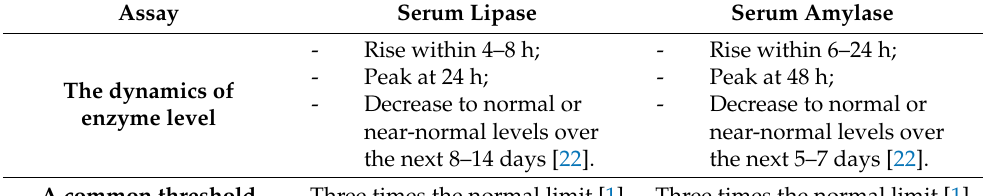
Table 2. Cont. Assay Serum Lipase Serum Amylase The dynamics of enzyme level